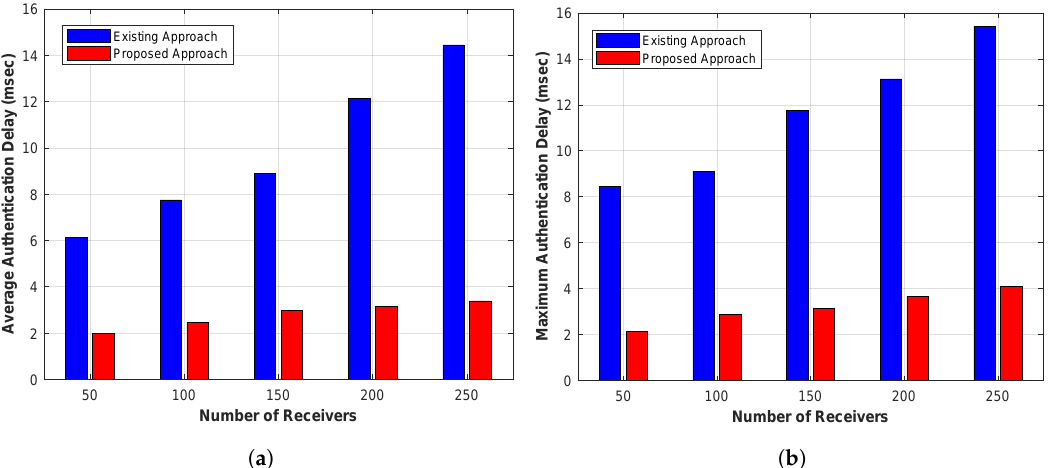
Figure 12. ( a ) Average authentication delay against the number of users (receivers). ( b ) Maximum authentication delay against the number of users (receivers).